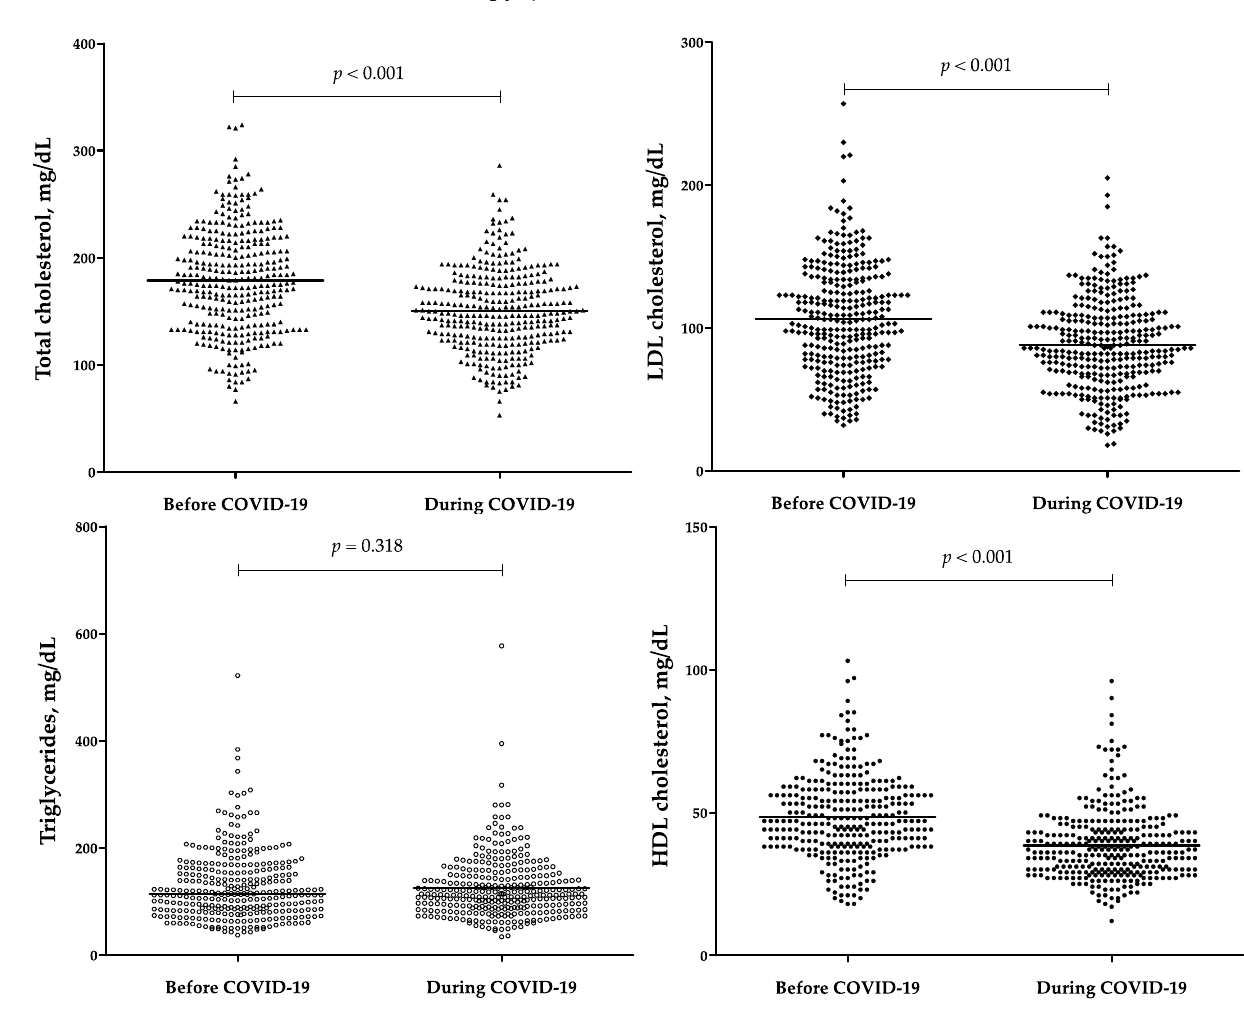
Figure 2. Lipid profile parameters before COVID-19 (from 1 month up to 1 year) and during COVID-19 (at hospital admission due to COVID-19). COVID-19, coronavirus disease 2019; HDL, high-density lipoprotein cholesterol; LDL, low-density lipoprotein cholesterol. Statistical significance was assessed through the paired samples t-test and the paired samples Wilcoxon test for parametric variables (i.e., total cholesterol, LDL cholesterol, HDL cholesterol) and nonparametric variables (i.e., triglycerides),